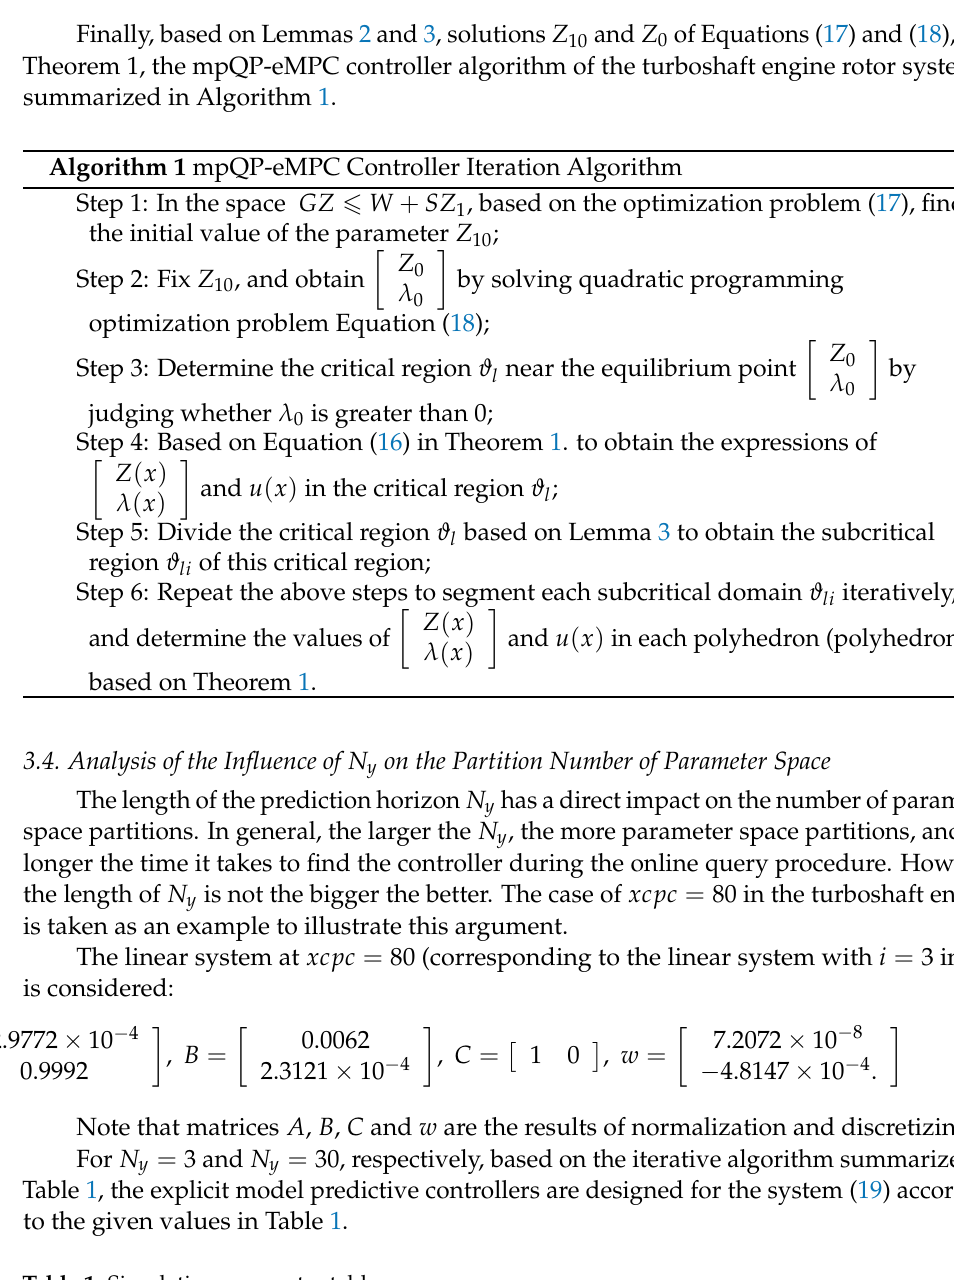
Table 1. Simulation parameter